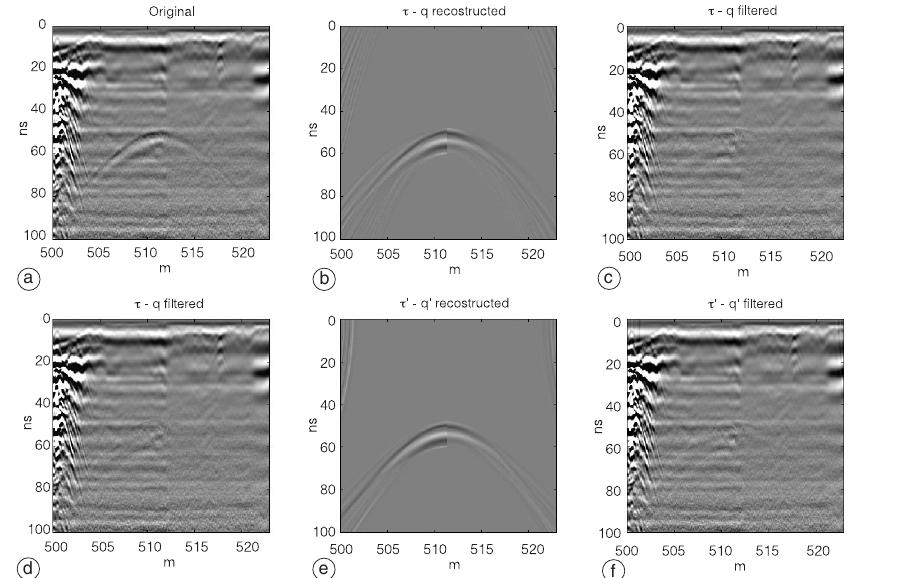
Fig. 9a-f. Example 3: comparison of the results obtained for surface-scattering removal by means of different Radon based methods (linear RT in the hyperbolically windowed domain, parabolic RT in the original and in the time-stretched